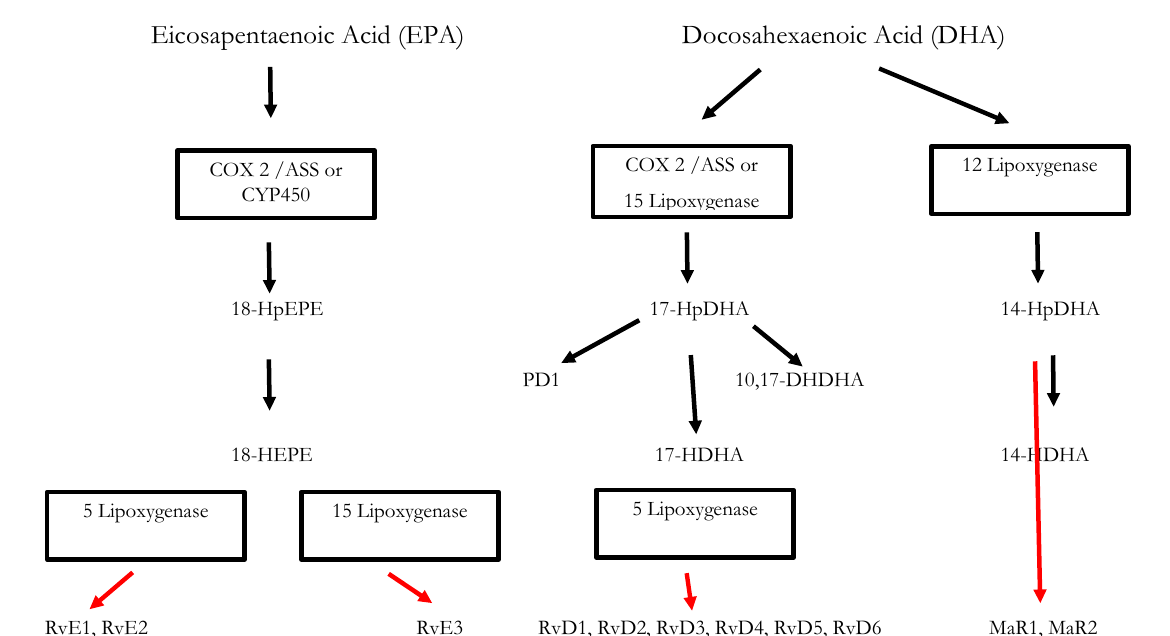
Figure 1. Biosynthesis of the SPMs Resolvins, Protectins and Maresins. EPA; Eicosapentaenoic Acid; 18-HpEPE, 17-HpDHA, 14-HPDHA: precursors of the SPMs during biosynthesis; Cox-1/2: Cyclooxygenases. ASS triggers biosynthesis of 18-HpEPE, 17-HpDHA intermediates via modification of Cox-enzymes. Maresins are produced by macrophages via a preliminary lipoxygenation step. Further lipoxygenases are required for SPM biosynthesis as depicted in Figure 1 [25].